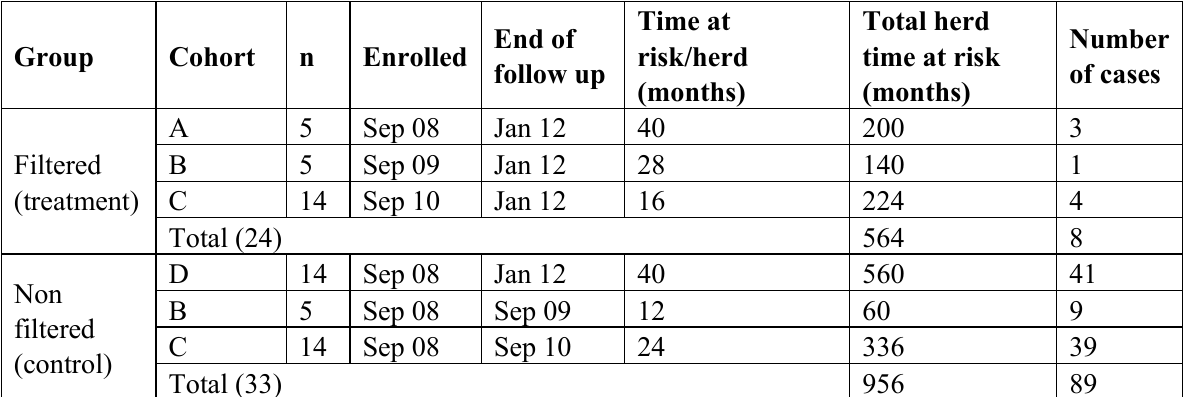
Table 2. Summary of new porcine reproductive and respiratory syndrome virus (PRRSV) infections in contemporary filtered and non-filtered breeding